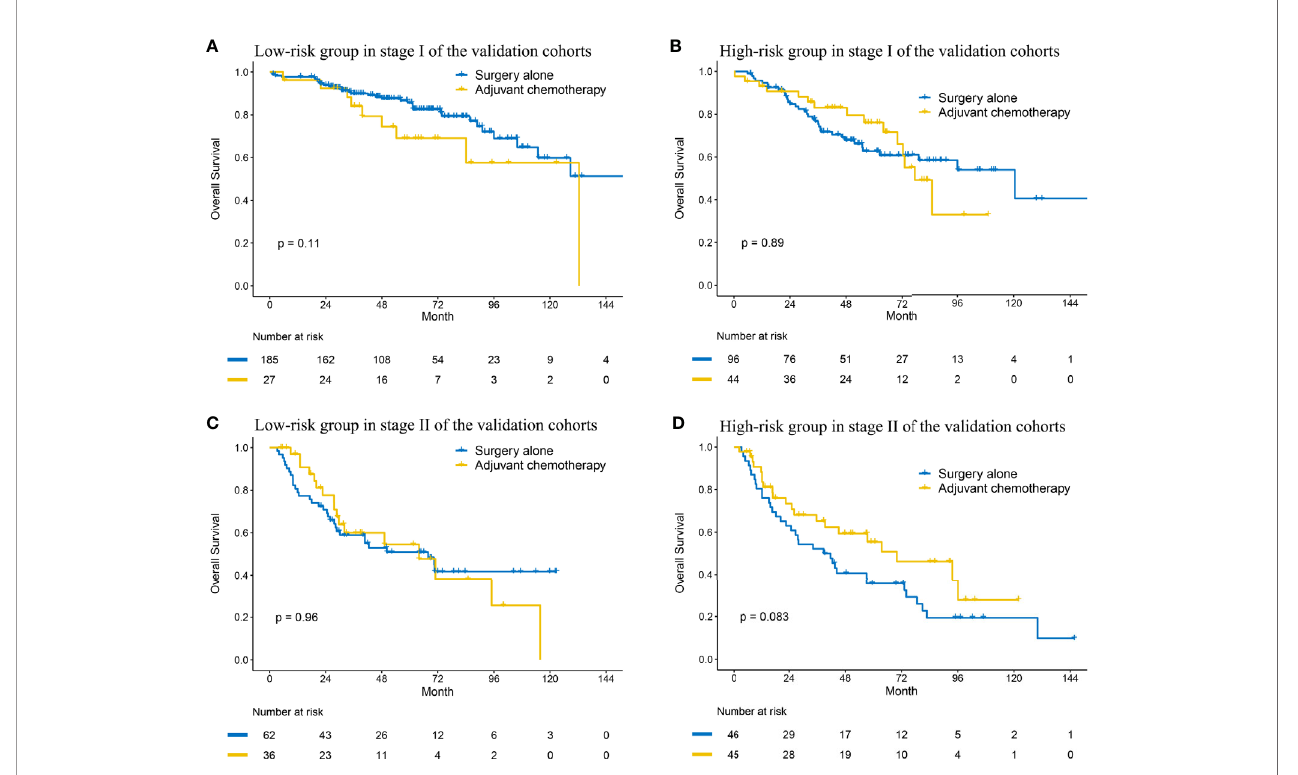
FIGURE 4 | Kaplan – Meier curves of overall survival regarding adjuvant chemotherapy in patients with stage I (A, B) and stage II (C, D) disease at low and high risk in the validation